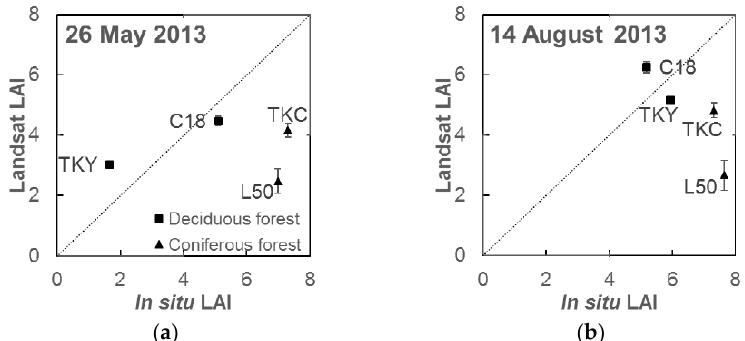
Figure 7. Scatterplot between Landsat OLI imagery–based LAI estimations and ground truth LAI for the four study plots dated 26 May 2013 ( a ) and 14 August 2013 ( b ). Error bars represent standard errors.